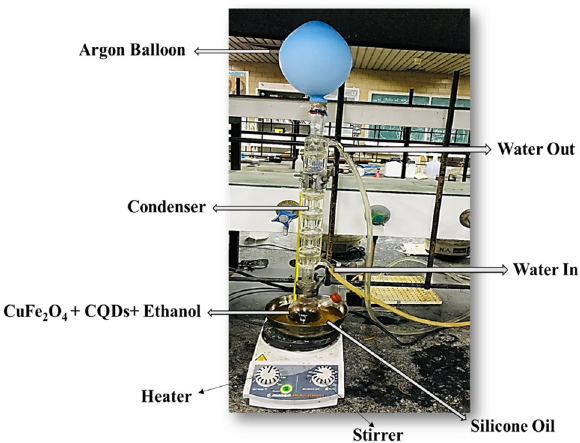
Figure 2. Representation of co-precipitation technique applied for fabrication of CuFe 2 O 4 @CQD nanocomposite.